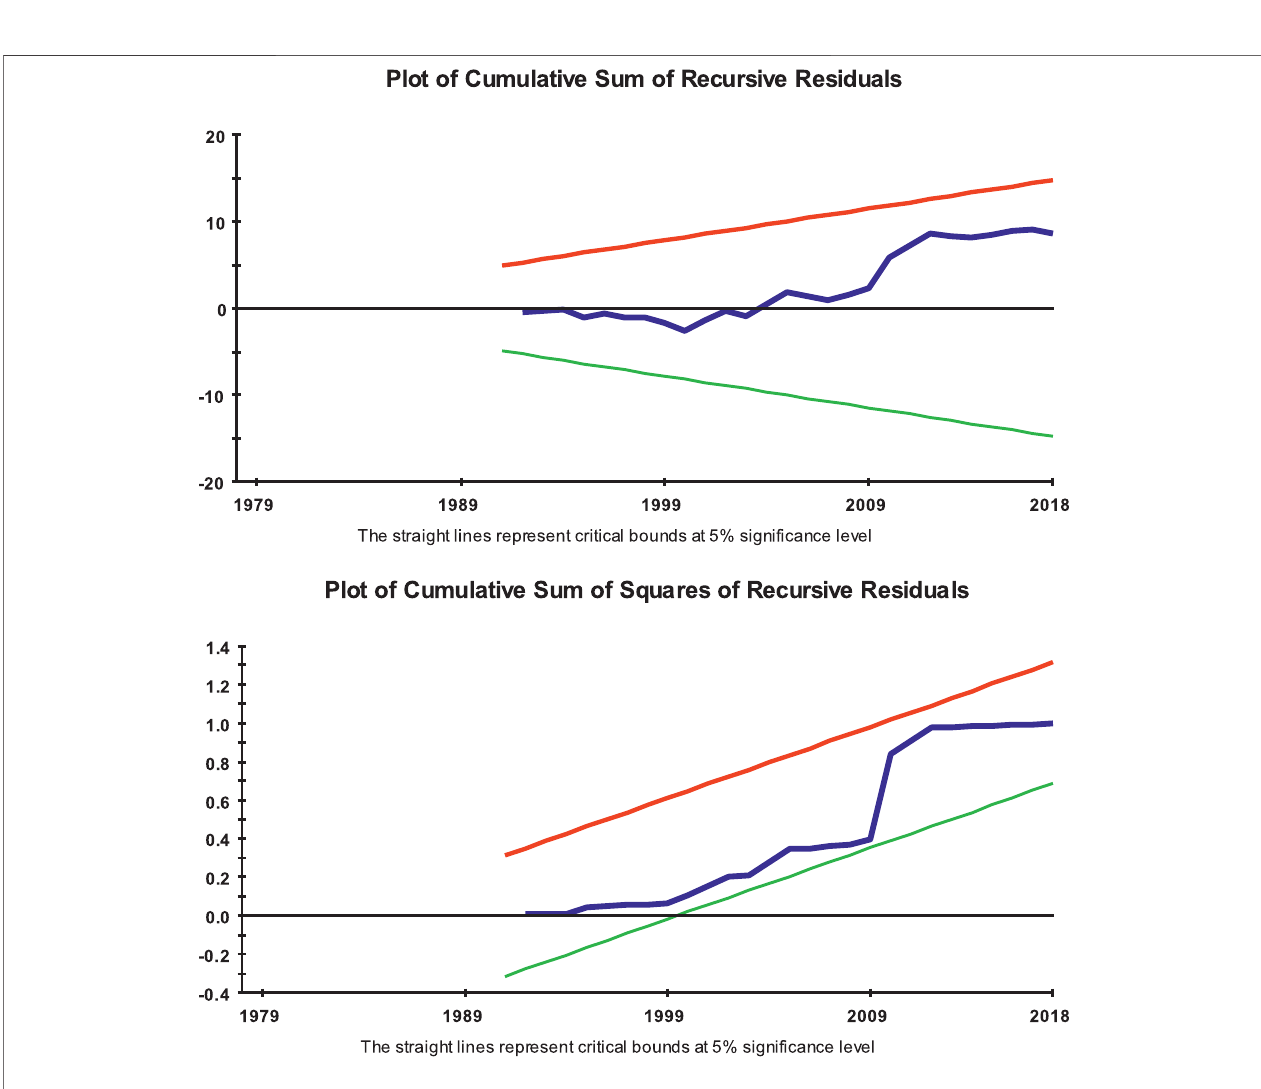
FIGURE 2 | CUSUM and